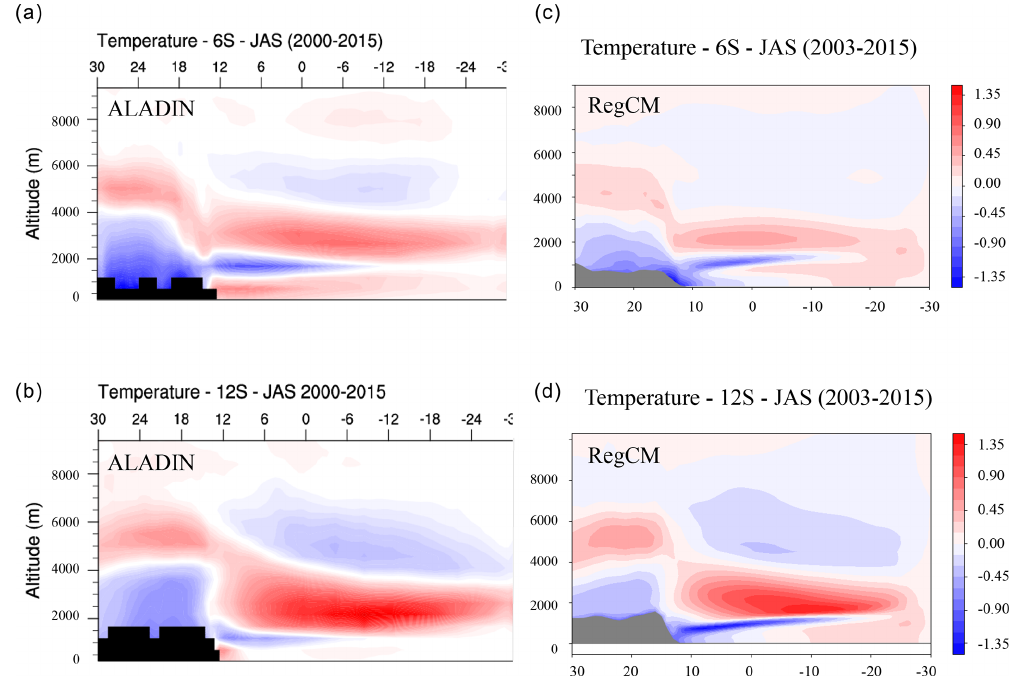
Figure 10. Seasonal-mean (JAS) changes (SMK minus CTL simulations) in the vertical profiles of air temperature due to BBAs at two latitudes (6 and 12 ◦ S), for the ALADIN ( a, b , period 2000–2015) and RegCM ( c, d , period 2003–2015)